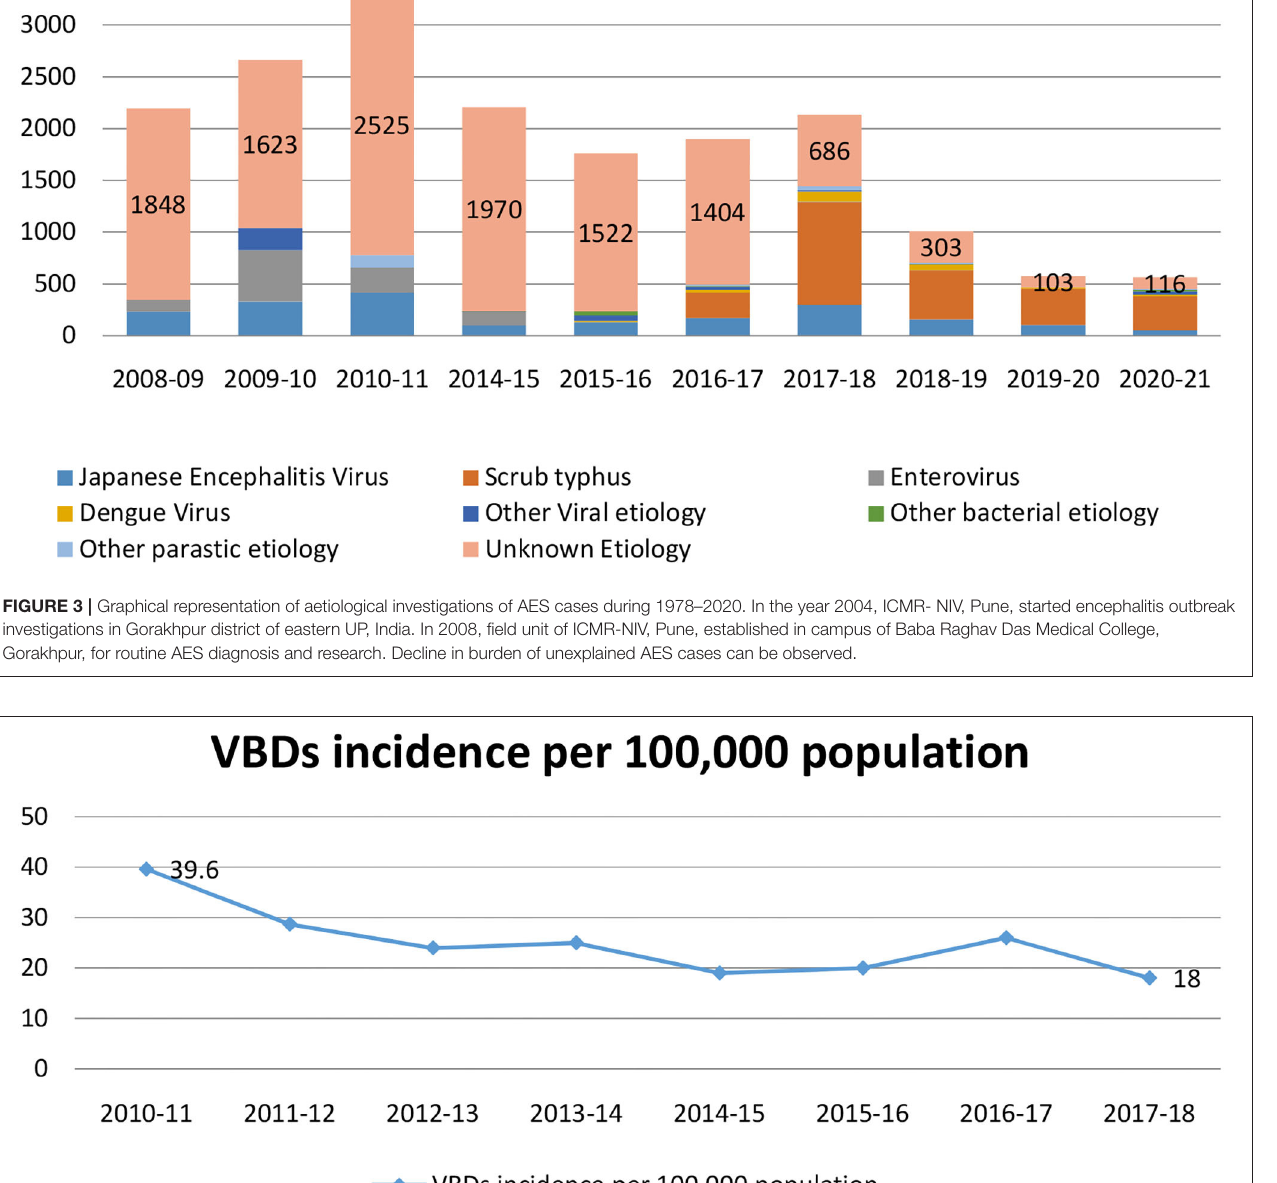
on JE vaccine coverage found low overall vaccine coverage (72.3% for single dose and 42.3% for booster/second dose) in Gorakhpur division (4 districts i.e., Deoria, Kushinagar, Gorakhpur, Maharajganj) (37). Decline in JE cases can be observed in Figure